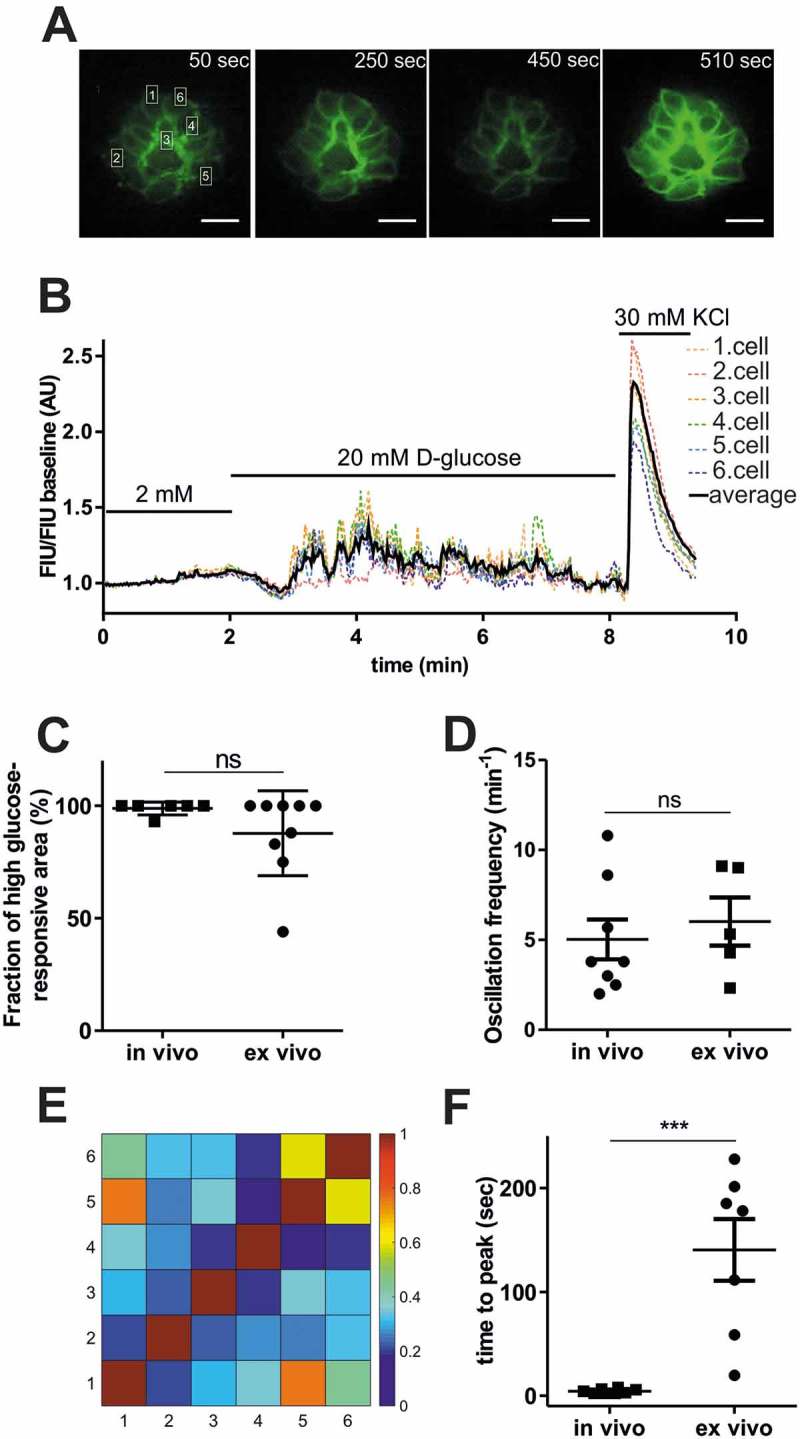
Comparison of ex vivo and in vivo glucose responsiveness.(A) Fluorescence image series of isolated pancreatic islet showing GCaMP6 signal alteration at the indicated time-points shown in (B) applying 2 mM, 20 mM glucose and 30 mM KCl. Single β-cell is defined as ˜3 × 5 μm white rectangular selection drawn around one piece of the GCamP6s-expressing membrane located between two individual β-cells. Scale bar = 10 µm. (B) Single cell GCaMP6s fluorescence traces for isolated islet from wild-type zebrafish larvae (5 dpf) after applying 2 mM, 20 mM glucose followed by 30 mM KCl. FIU intensities for the single cells (n = 6 cells) were determined using Image-J, normalized to the FIU baseline (intensities measured in the first 2 min when 2 mM glucose was applied) and displayed as FIU/FIU baseline (AU) for single cells (coloured dotted line) and for the average of the singles cells in the islet (black line). (C) Quantification showing the percentage of β-cells that respond upon stimulation with 20 mM glucose, ex vivo and the percentage of glucose-responsive β-cell area after intravenous injection of >10 mM glucose in vivo. (n = 8 and 9 larvae were analyzed, in vivo and ex vivo, respectively) (D) Average oscillation frequencies of 4 selected β-cell areas of the pancreatic islet (n = 8 islets, in each islet 4 β-cell areas were manually selected based on the red RFP expression) after intravenous injection (~1–2 nl of 0.5 M glucose, >10 mM final concentration) of 5 dpf old zebrafish larvae (in vivo, imaged by epifluorescence microscope), and average oscillation frequencies of individual β-cells (n = 5 islets, in each islet >6 cells were analyzed) of the isolated pancreatic islets after 20 mM glucose stimulation (ex vivo, imaged by spinning disc microscope). Oscillation peaks were identified by PeakCaller, MATLAB on the FIU/FIU baseline traces of individual β-cells/areas (see Sup. Fig. 2A). The peak number was divided by the time duration until oscillation was observed (˜30–60 sec, in vivo, ˜150–300 sec, ex vivo) (E) Cross-correlation matrix (determined by PeakCaller, MATLAB) of the islet between individual cells shown in (A) and (B), with color key to the right of the matrix graph. Numbers on the x and y axes represent individual cells that are marked in (A) and (B). (F) Time to peak calculated from the time point when addition of the new glucose solution was finished in isolated islets, ex vivo (n = 7 islets, the addition took in average ˜38 seconds), and when glucose was injected in living zebrafish larvae, in vivo (n = 8 islets from n = 8 larvae). Data are shown as mean values ±s.e.m., *p < 0.05 in unpaired, two-tailed t-test between ex vivo and in vivo groups in (C), (D) and (F). FIU = Fluorescence Intensity Units (AU, Arbitrary Units).